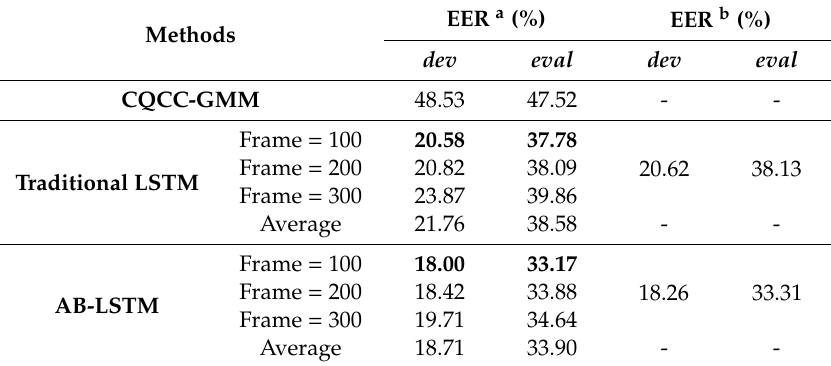
Table 4. EER a (%) and EER b (%) for di ff erent methods when SNR = − 5